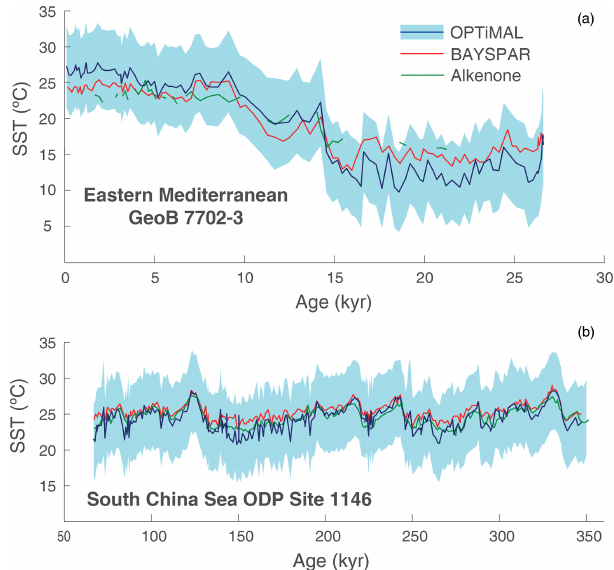
. (cid:48) SSTs. Shaded 37